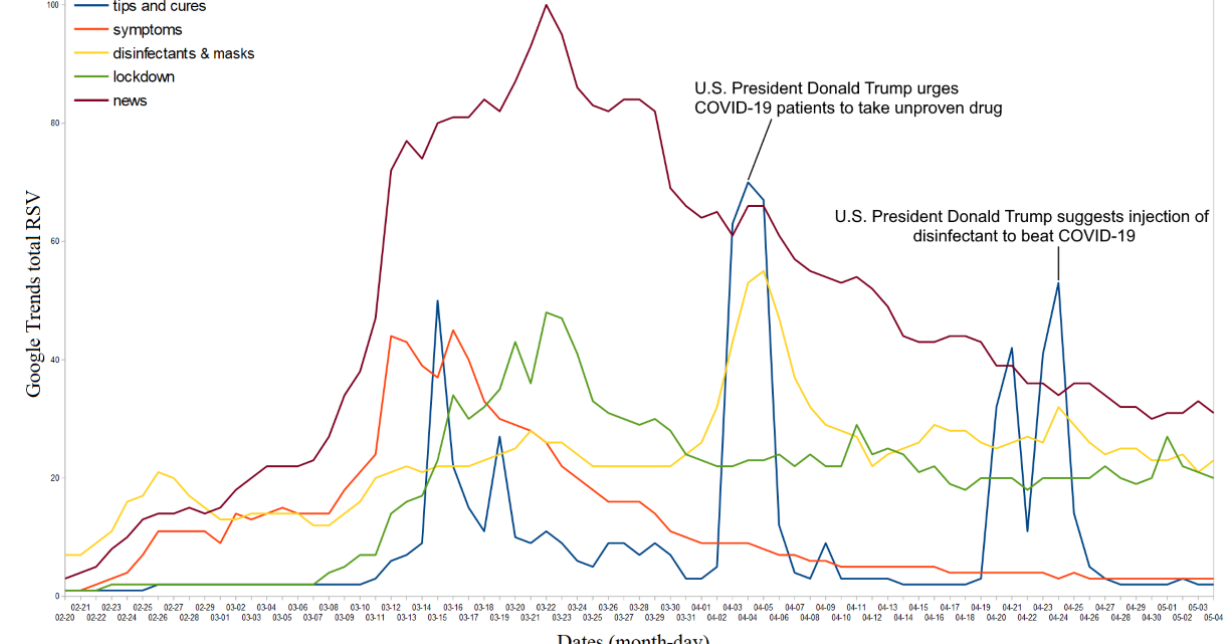
Figure 4. Top global web searches related to health, precautions, and coronavirus disease (COVID-19) news. RSV: relative search volume.